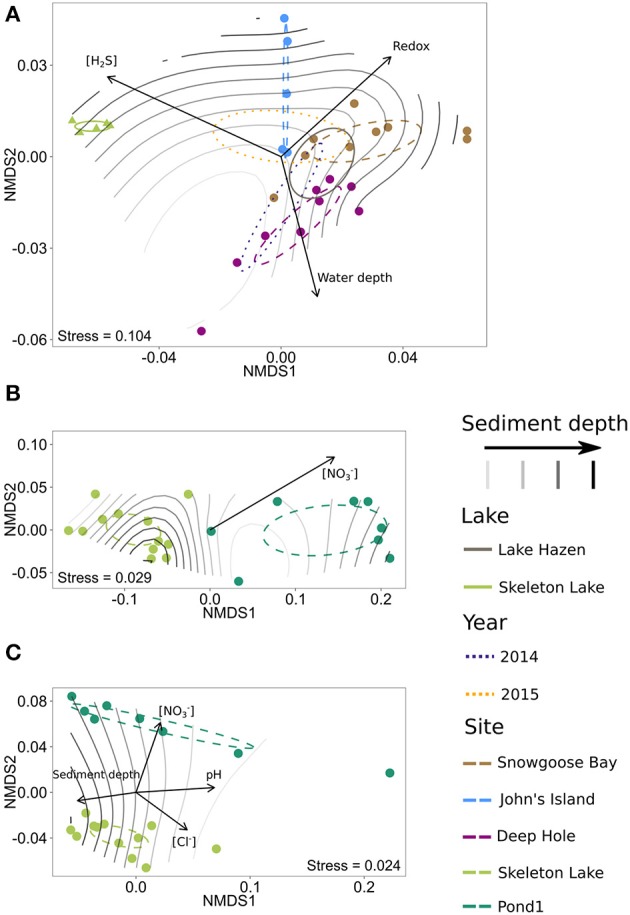
NMDS ordinations of phylogenetic DPCoA distances of the samples, with significantly correlated physicochemical variables as vectors. 95%-confidence interval for centroids of sample categories (lake, year, and site, where applicable) is shown with ellipses and sediment depth is overlaid on the plots as a surface fit. (A) Spring 2014/2015 with universal primers. (B) Summer 2015 with archaeal primers. (C) Summer 2015 with bacterial primers.